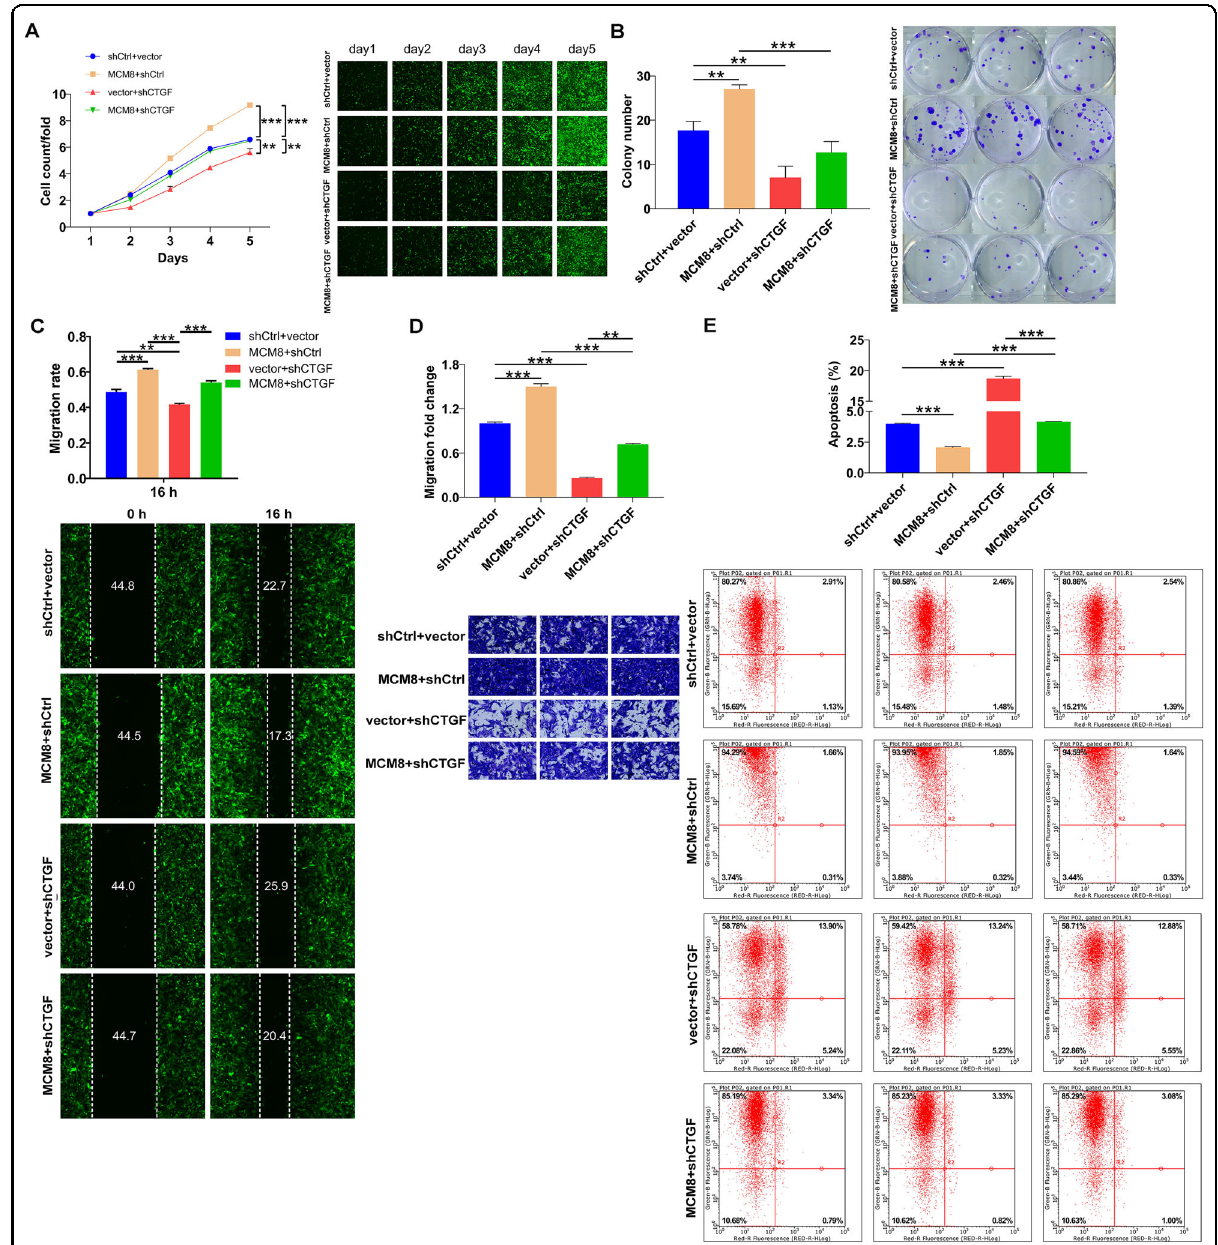
Fig. 6 Knockdown of CTGF alleviated the promotion of osteosarcoma caused by MCM8 overexpression. A Celigo cell counting assay was employed to show the effects of mere MCM8 overexpression, mere CTGF knockdown and concurrent MCM8 overexpression and CTGF knockdown on cell proliferation. B Colony formation assay was used to evaluate the effects of mere MCM8 overexpression, mere CTGF knockdown and concurrent MCM8 overexpression and CTGF knockdown on colony formation. C The effects of mere MCM8 overexpression, mere CTGF knockdown and concurrent MCM8 overexpression and CTGF knockdown on cell migration were evaluated by wound-healing assay. D The effects of mere MCM8 overexpression, mere CTGF knockdown and concurrent MCM8 overexpression and CTGF knockdown on cell migration were evaluated by transwell assay. Magni fi cation times: ×200. E The effects of mere MCM8 overexpression, mere CTGF knockdown and concurrent MCM8 overexpression and CTGF knockdown on cell apoptosis were evaluated by fl ow cytometry. Results were presented as mean ± SD. * P < 0.05, *** P <